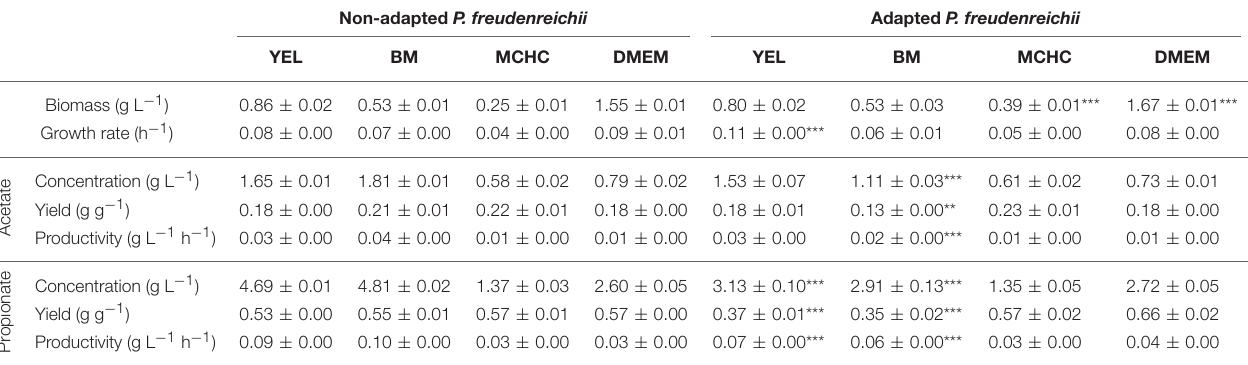
TABLE 1 | Kinetics of the fermentations conducted with non-adapted and adapted (digestive stress challenged bacteria) Propionibacterium freudenreichii . Non-adapted P.